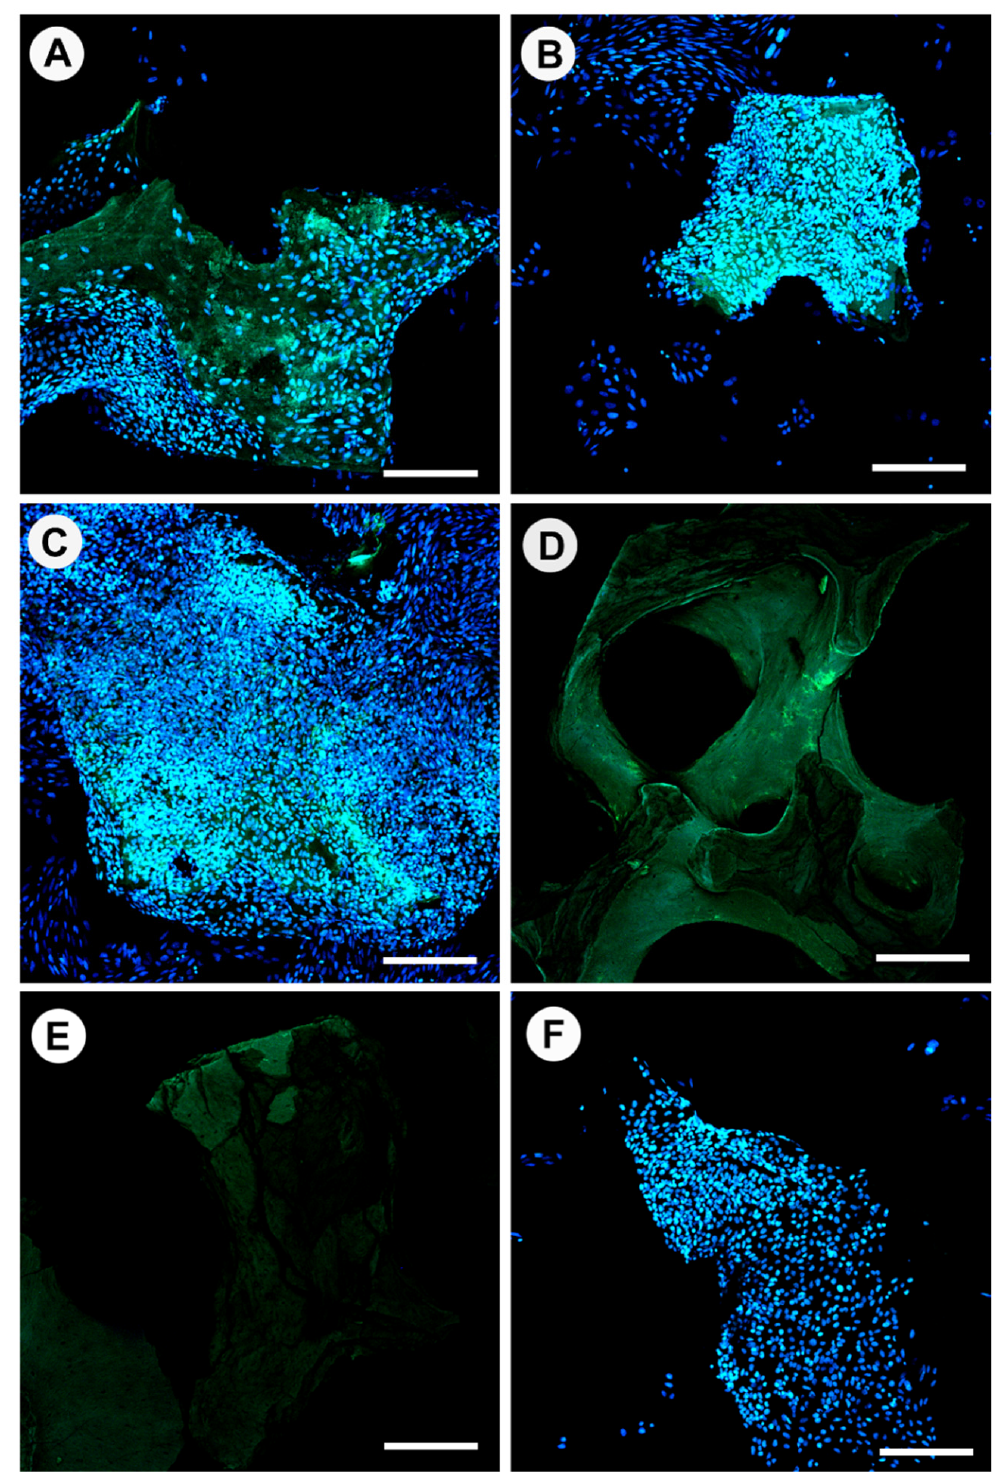
Figure 7. Confocal laser scanning microscopy (CLSM) of osteoblast nuclei (blue) and osteocalcin (green) cultured in osteogenic media for 21 days on bone scaffolds heat-treated at 100 °C ( A ), 130 °C ( B ), 160 °C ( C ), 190 °C ( D ), 220 °C ( E ), Bio-Oss ® ( F ). Scale bar = 200 µm.